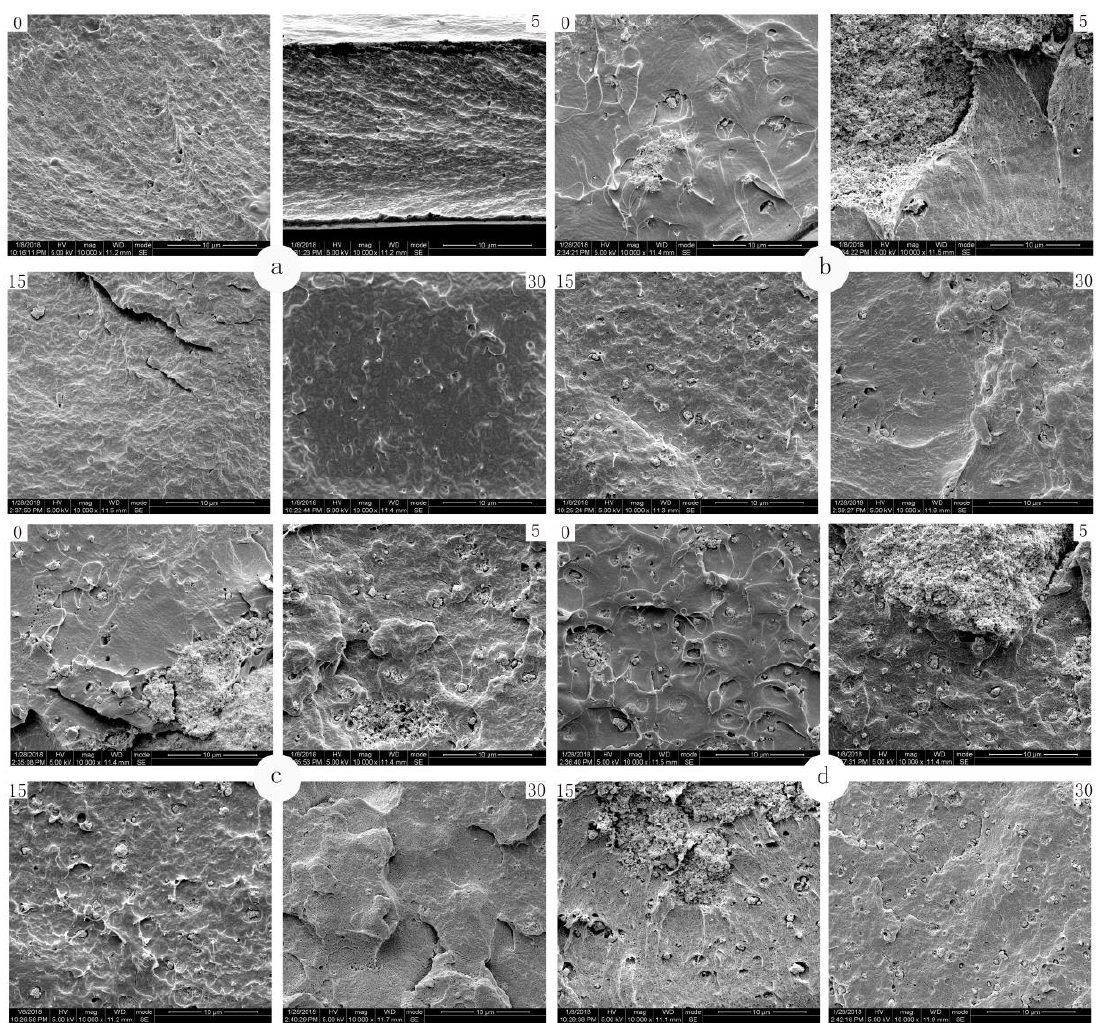
Figure 2. S canning electron microscopy (SEM) images of ( a ) PLA, ( b ) PLA/Ti5, ( c ) PLA/Ti10, and ( d